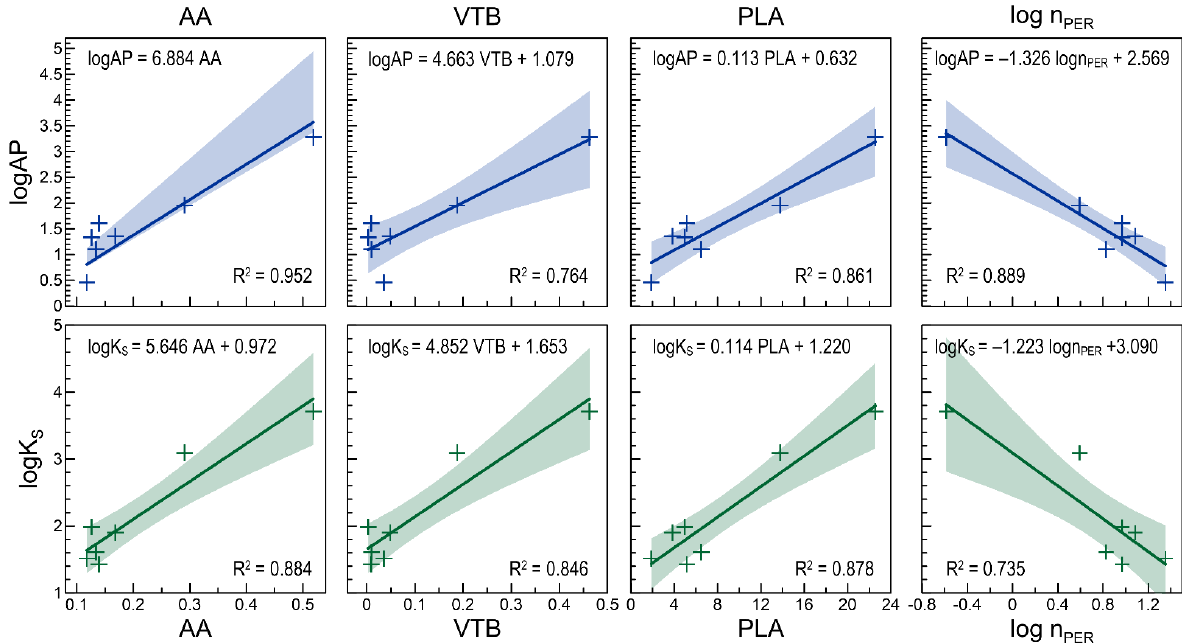
Figure 4. Relationships between air permeability (log AP , upper row) and saturated hydraulic conductivity (log K S , lower row) and the morphological parameters of pore structure: AA –macroporosity by image analysis; VTB –relative volume of pores overlapping the top and bottom edge of the image; PLA –relative length of pore path; and log n PER –percolation number. The shaded area represents a 95% confidence level.